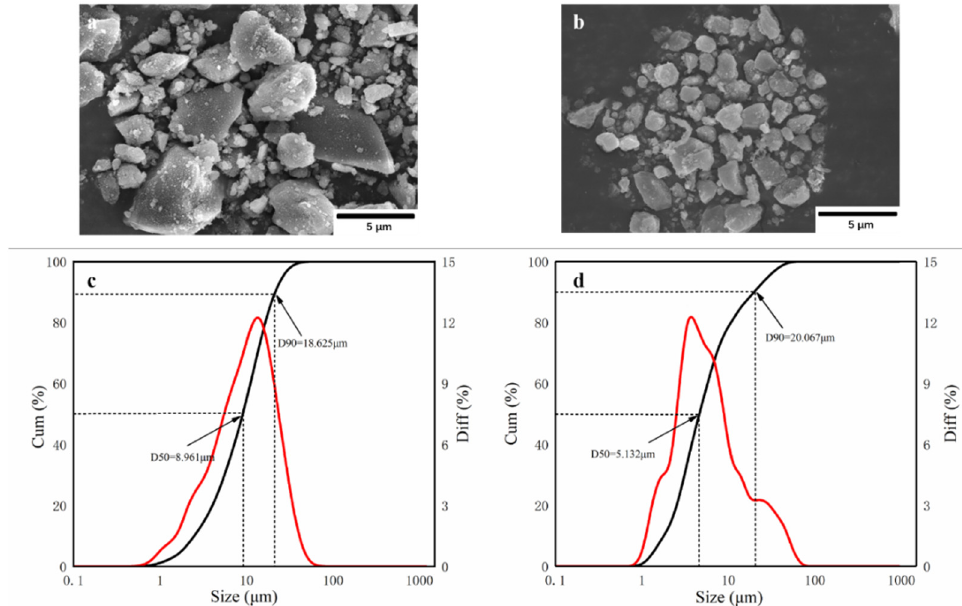
Figure 3. Scanning electron microscopy (SEM) images of ( a ) ultrafine NH 4 H 2 PO 4 powder and ( b ) ultrafine struvite powder; Particle size and size distribution of ( c ) ultrafine NH 4 H 2 PO 4 powder and ( d ) ultrafine struvite powder.